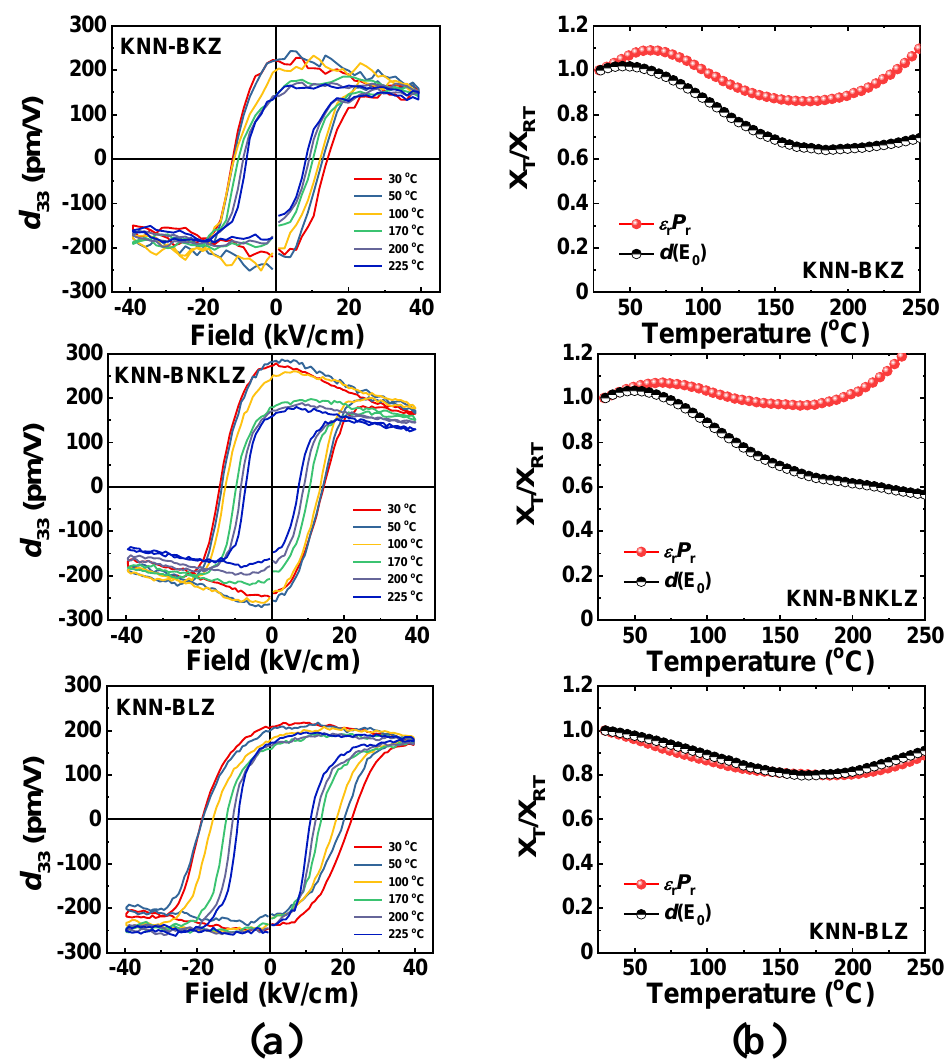
Figure 3. ( a ) Piezoelectric coefficient d 33 versus electric field ( D – E ) loops of the KNN-BKZ, KNN-BNKLZ, and KNN-BLZ ceramics measured at a frequency of 1 Hz and ( b ) normalized values of ε r P r and d ( E 0 ) values versus temperature.